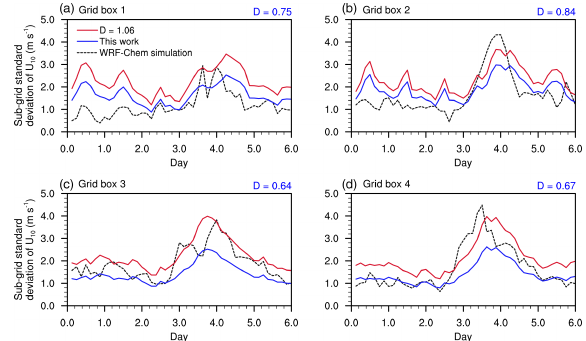
Figure 12. As in Fig. 11, but for the four 225km boxes at the center of the WRF domain near the Taklamakan Desert. The D values used for the blue curves are derived from the ECMWF analysis of year 2011 for 2 ◦ lat × 2 ◦ long grid cells that are closest to the 225km